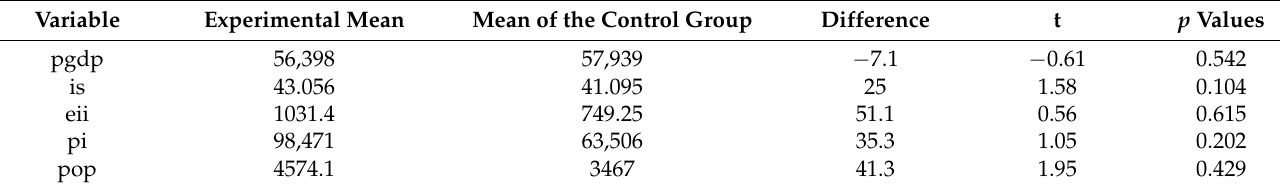
Table 6. Validity test of propensity score matching.